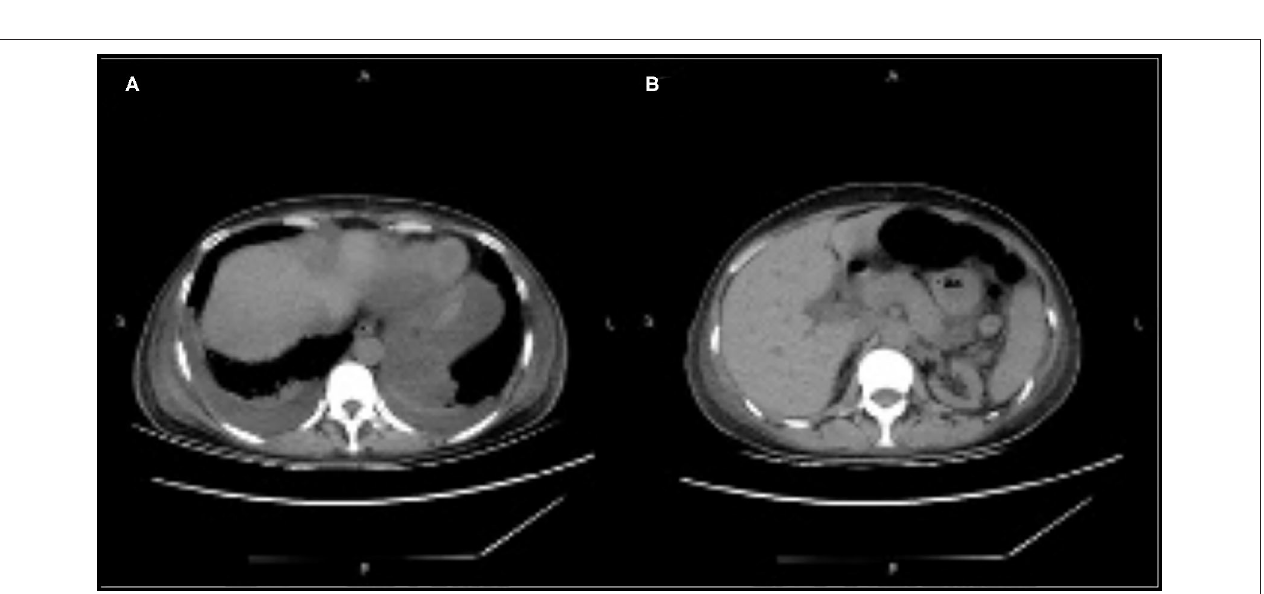
FIGURE 1 | (A–C) Abdominal computed tomography scan showing pancreatic enlargement with peripancreatic inflammatory exudate, bilateral pleural effusion, and the transplanted kidney.